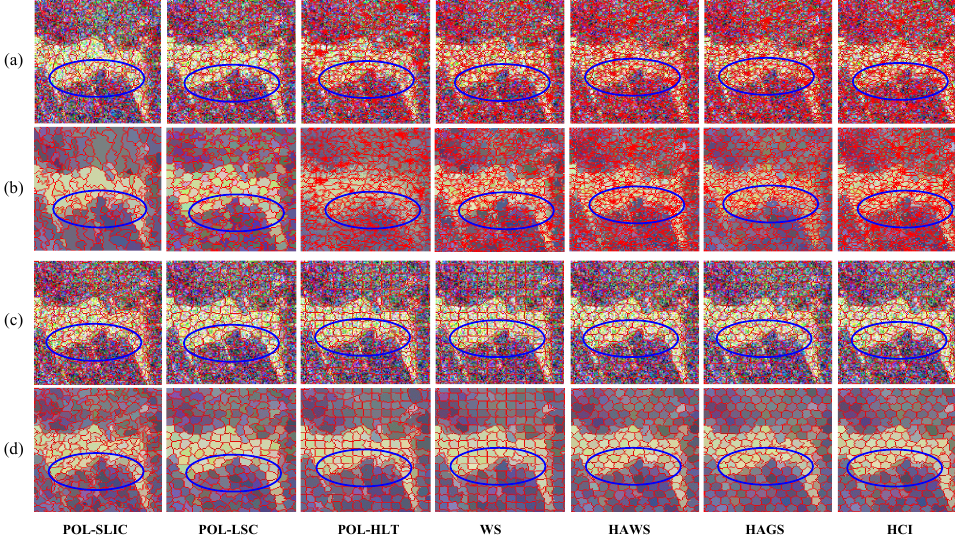
Figure 22. Enlarged regions at the upper left of RADARSAT-2 data set. ( a , b ) are the results based on the unfiltered image, ( c , d ) are the results based on the filtered image using Lee filter with w = 5. The first through seventh rows represent the results of the POL-SLIC, POL-LSC, POL-HLT, WS, HAWS, HAGS, and the proposed